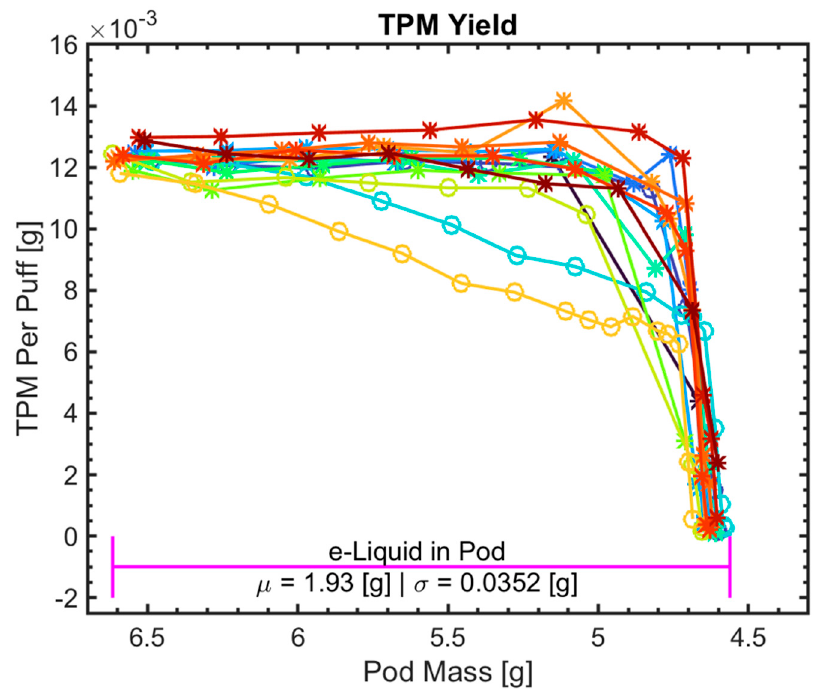
Figure 5. TPM yield per puff vs. pod mass for each session starting from brand new full pods until coil failure where the pod visually looks empty for N = 15 pods tested in this study. Each pod is represented by a different marker color.